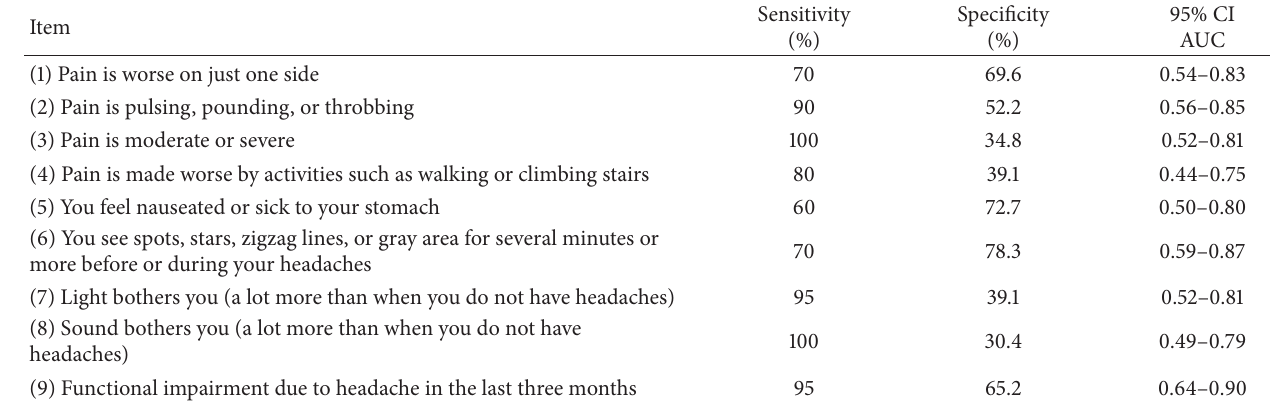
Table 3: Sensitivity and specificity of the Nine-Item Screener in patients with and without migraine.